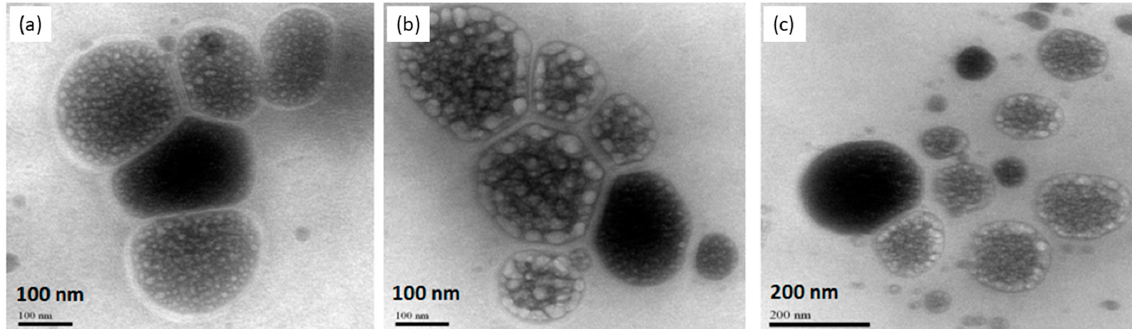
Figure 2. Transmission Electron Microscopy of CP entrapped into liposomes. PC + PL ( a ), PC + LP + CP ( b ), PC + EXT ( c ). Scale bars: 100 nm ( a , b ) and 200 nm ( c ).